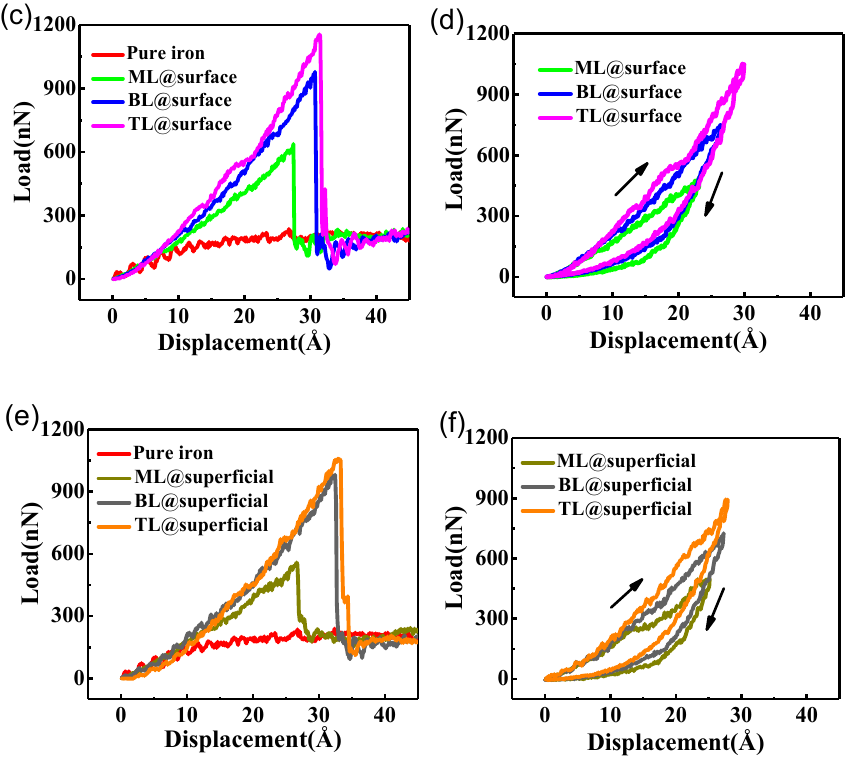
Figure 2. ( a ) Load-displacement curves of pure iron, composite with monolayer (ML) graphene on surface and in superficial zone; ( b ) loading-unloading curves of pure iron and composite with monolayer graphene; ( c ) load-displacement curves of pure iron and composite with different numbers of layers on the surface (ML, bilayer (BL), trilayer (TL)); ( d ) loading-unloading curves of three surface composite cases; ( e ) load-displacement curves of pure iron and composite with different number layers in superficial zone; ( f ) loading-unloading curves of three superficial composite cases.